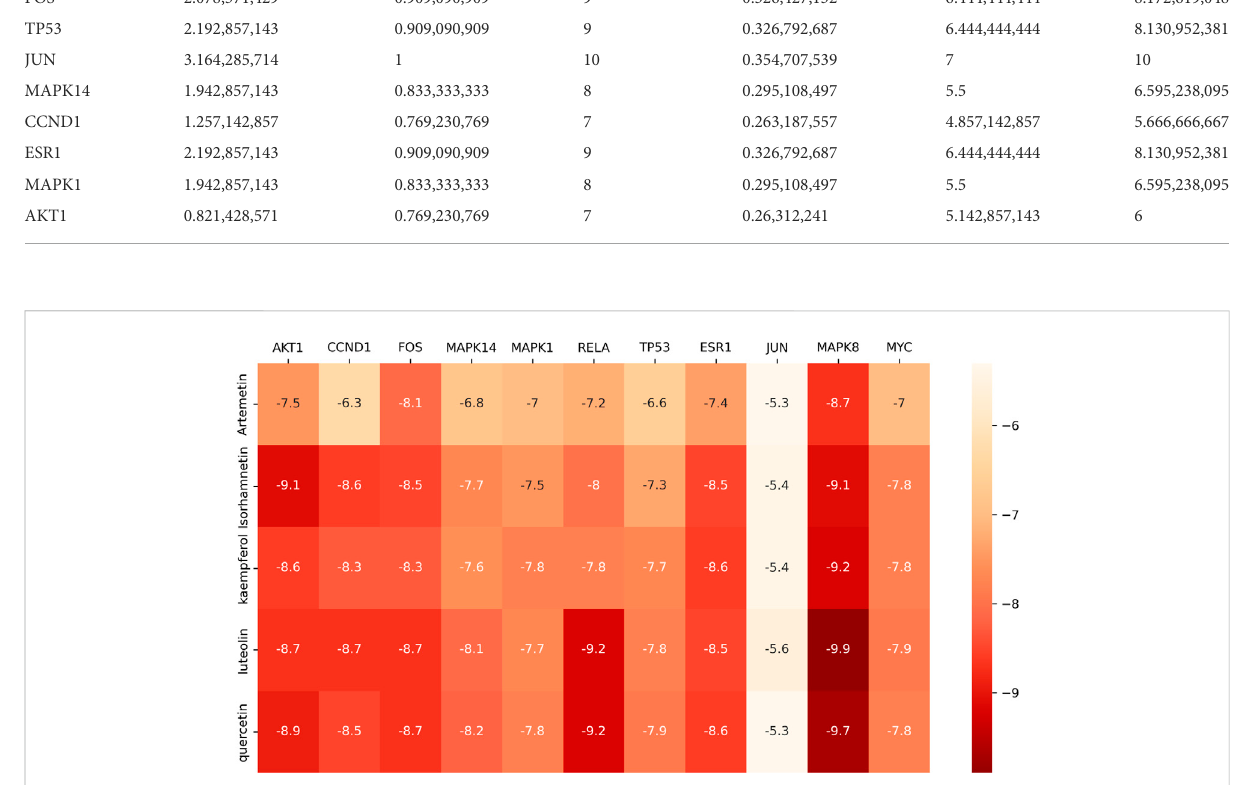
FIGURE 7 Thermal diagram of the molecular docking binding energy. The color from white to red indicated that the binding ability was weak to